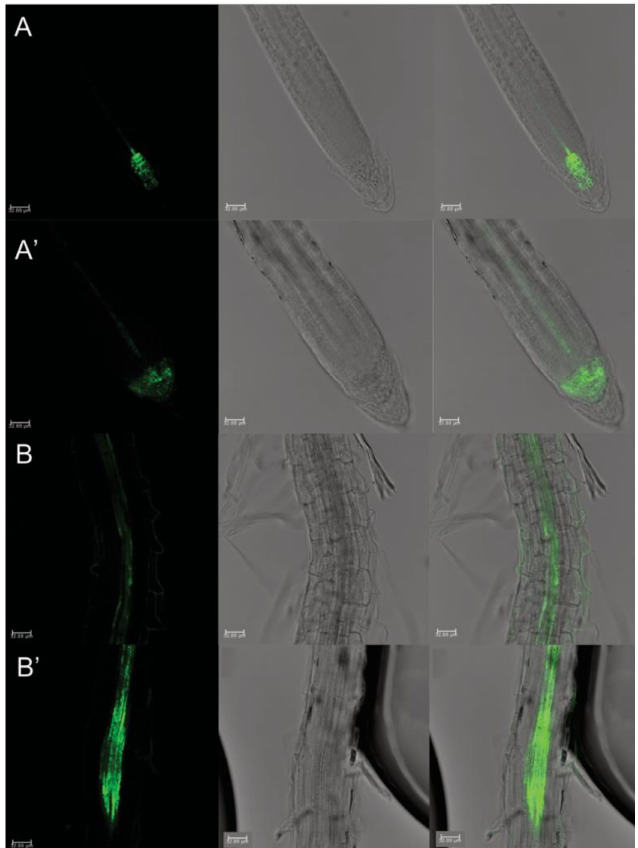
Figure 5. Primary root apex in seedlings of Arabidopsis pDR5::GFP transgenic line untreated ( A ) and treated with 50 µ M protodioscin for 6 d ( A’ ).Root maturation zone of A. thaliana pDR5::GFP transgenic line untreated ( B ) and treated with 50 µ M protodioscin for 6 d ( B’ ). Left side, GFP signal; center, transmission image; right side, merged image. Scale bars 32.88 µ m. N =